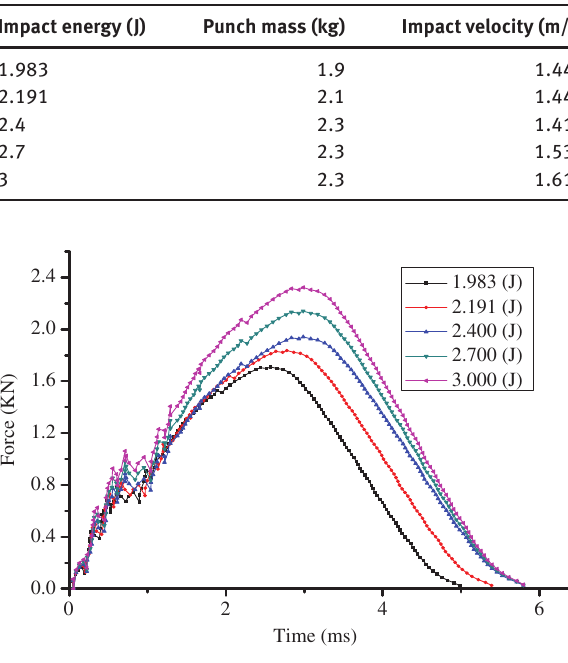
Figure 15: The variations of delamination area as a function of